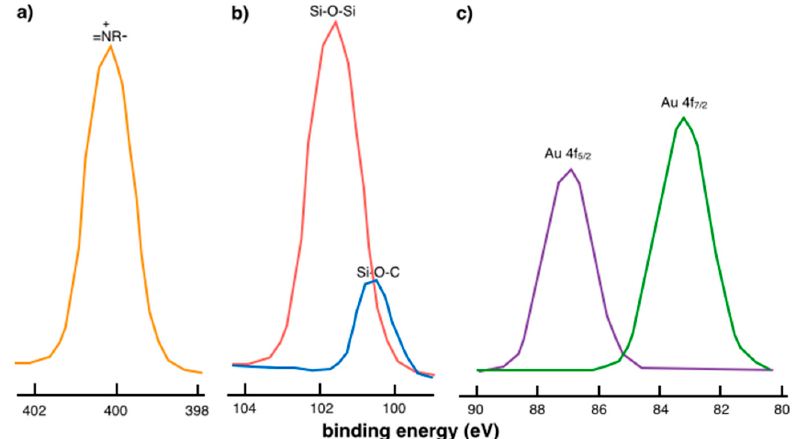
Figure 6. XPS spectra of the core level regions of Au–SiO 2 @IL(PF 6 ) for ( a ) N 1s, ( b ) Si 2p, and ( c ) Au 4f.